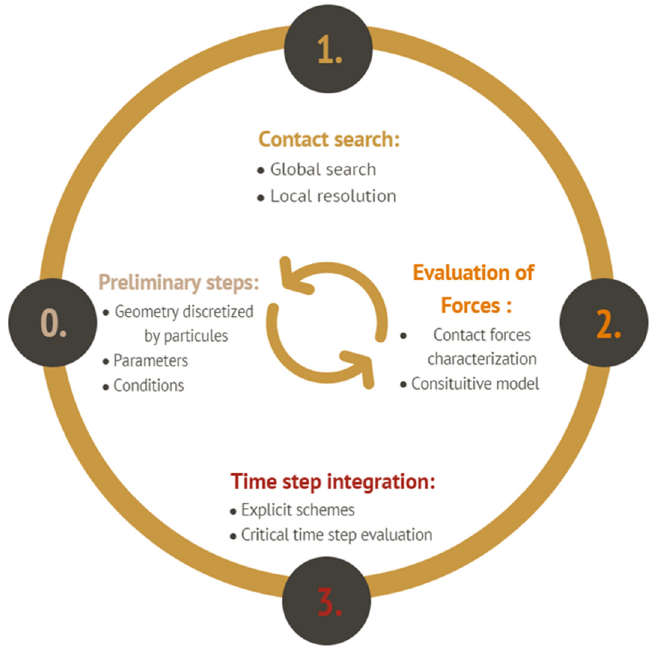
Figure 3. The basic steps for DEM modeling.